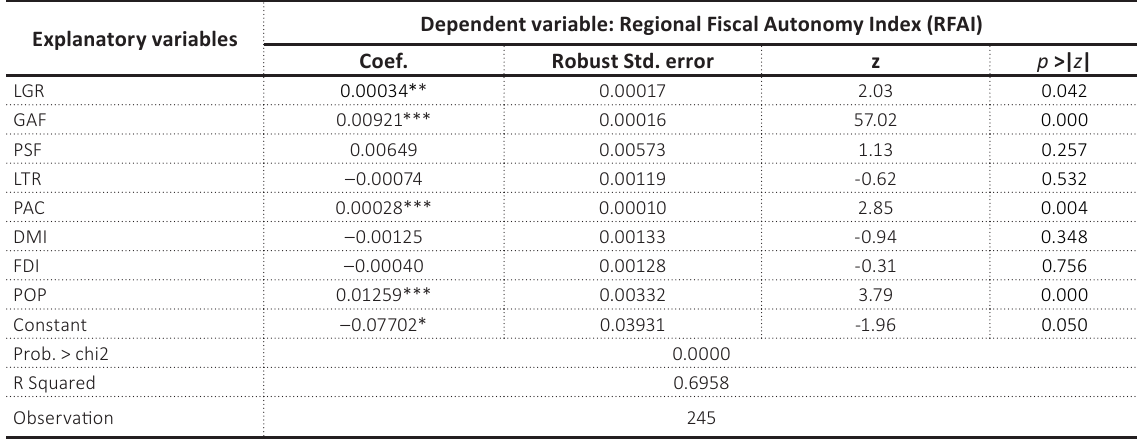
Table 5. Impact of the structure of local government budgets on local fiscal autonomy Explanatory